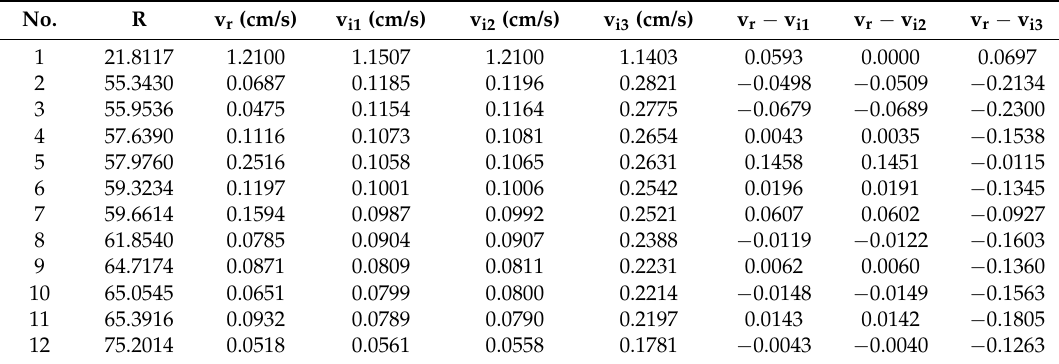
Table 5. Survey of recorded and calculated soil oscillation velocities for models 1, 2, and